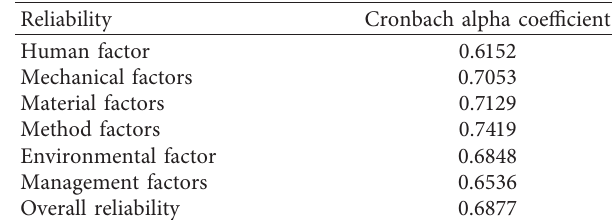
Table 4: Factor reliability